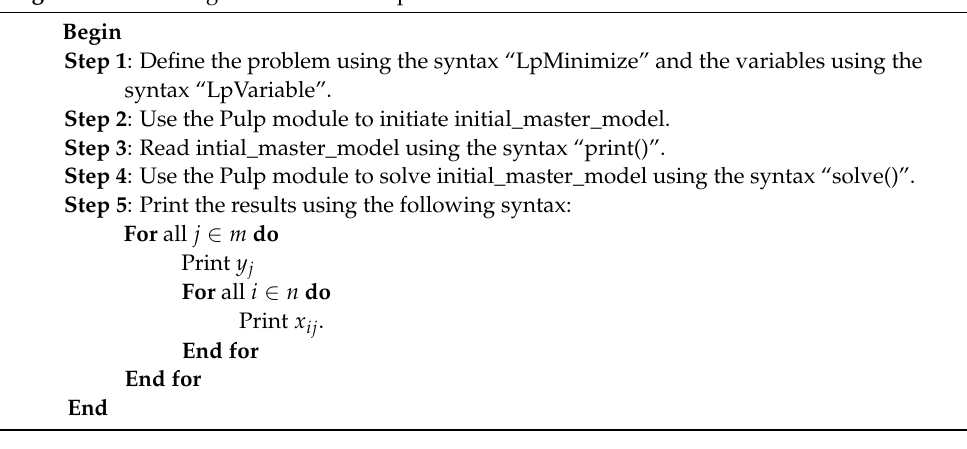
Algorithm 1: Solving the initial master problem.